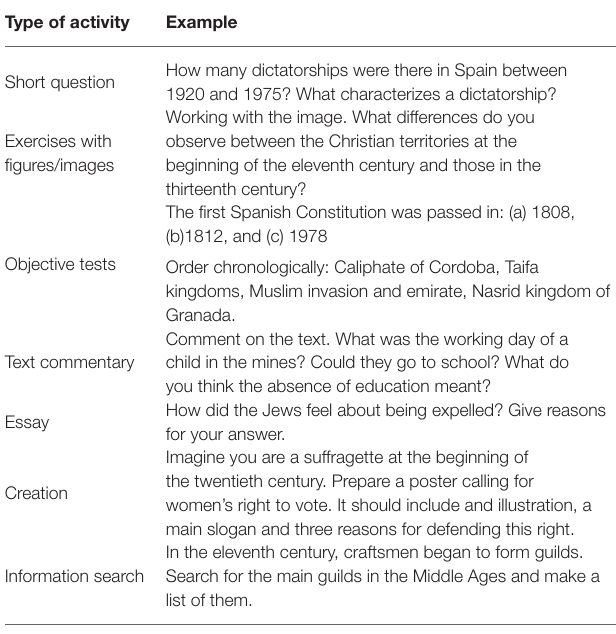
TABLE 1 | Type of activities in the